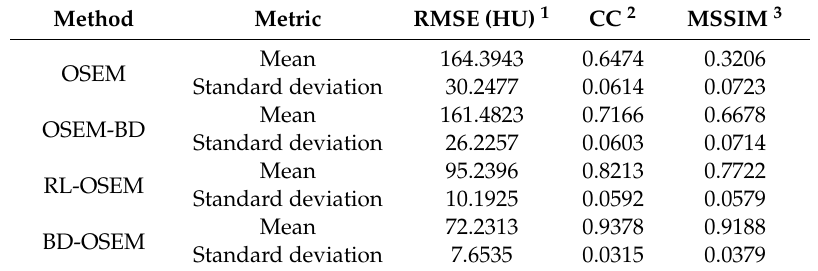
Table 1. EvaluationofmotionartifactreductionperformanceonShepp–Loganphantomwithslightmotion.